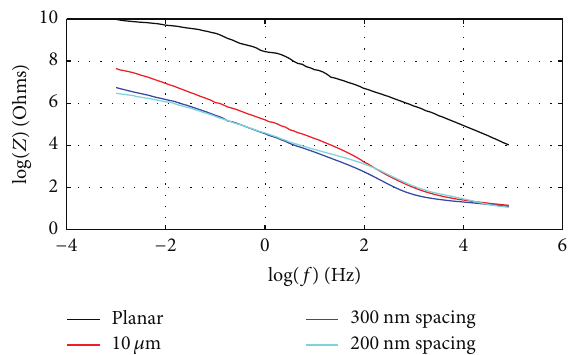
Figure 13: Bode plot of electrode impedance (on log/log